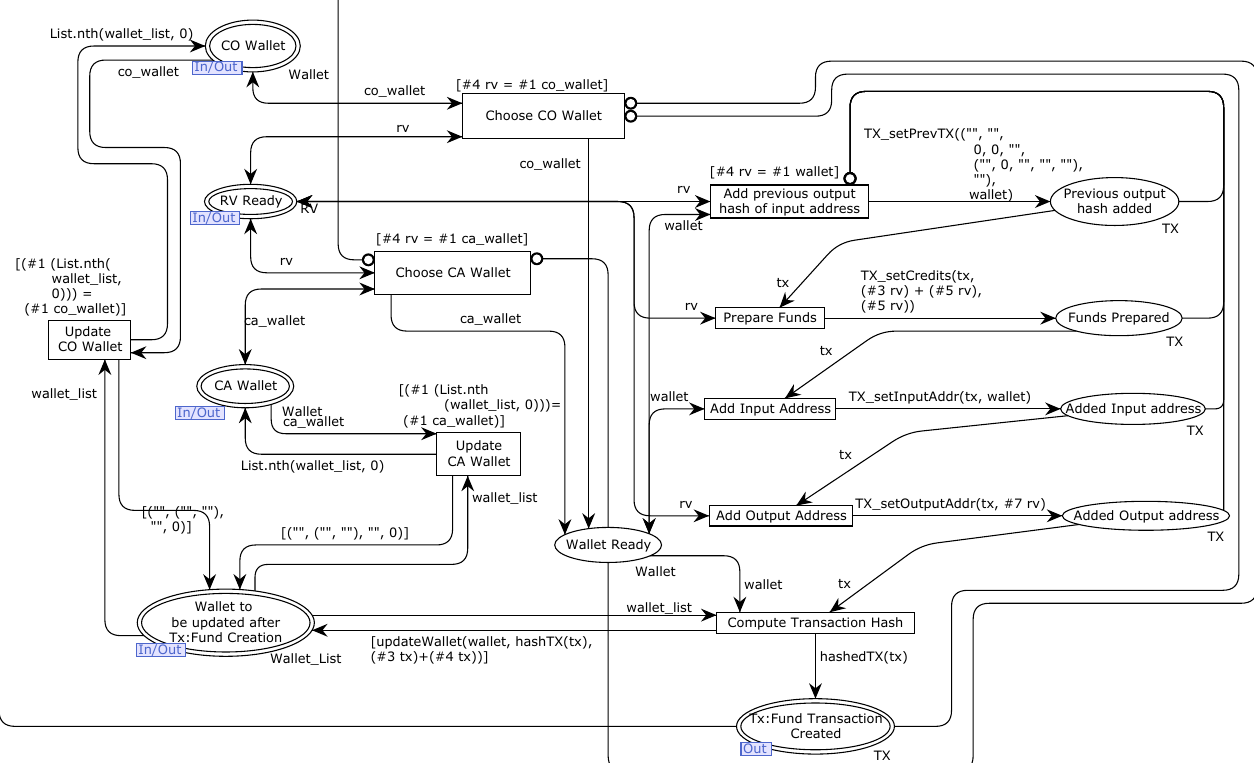
Figure 12. ‘Create Tx:Fund Transaction’ sub-module of the BlockVoke CPN